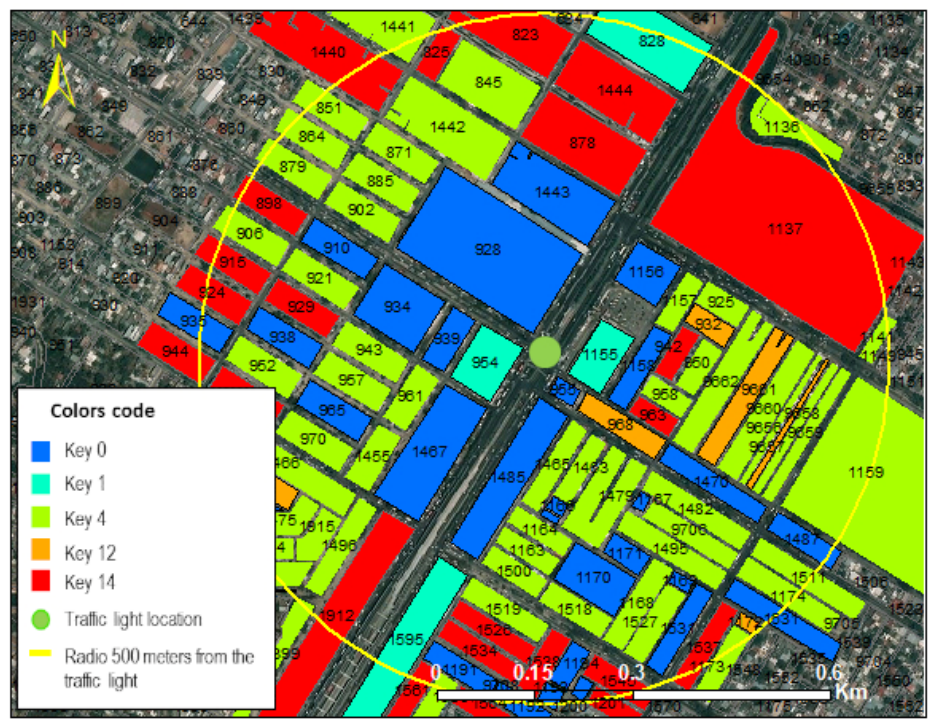
Figure 5. Tra ffi c light “entrance Col. Zapata” with the selected Figure 5. Traffic light “entrance Col. Zapata” with the selected blocks. Figure 5. Traffic light “entrance Col. Zapata” with the selected blocks.